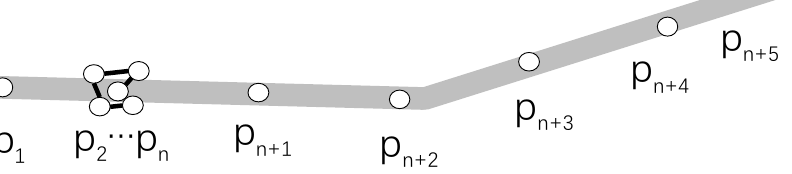
Figure 4. Noise points in the trajectory. Figure 5. Stationary points in the